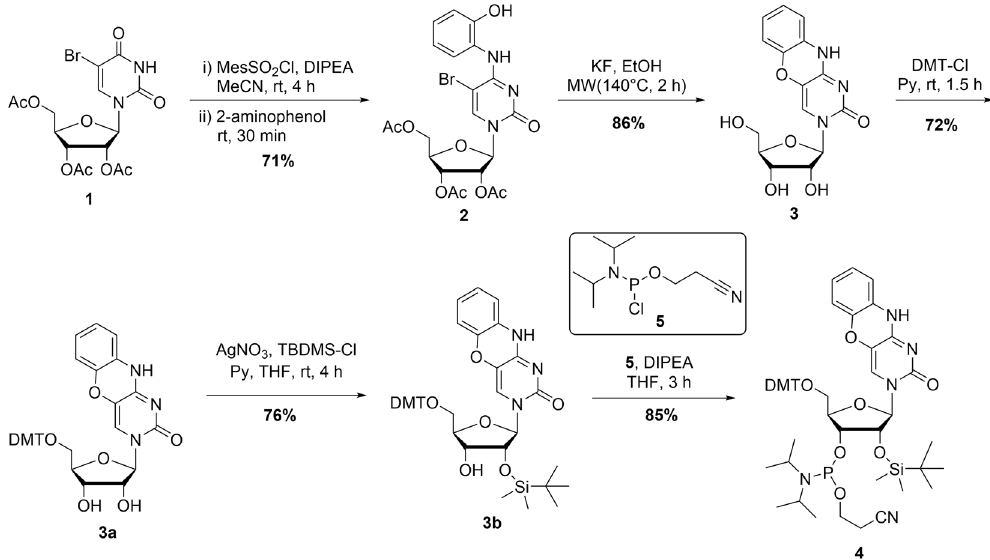
Figure 2. Synthesis of the tC O ribonucleoside phosphoramidite